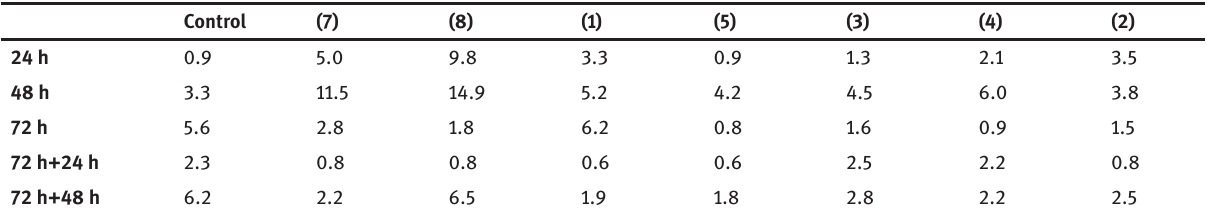
Table 1: The percentage of apoptotic HL60 cells cultured in the presence or absence of 100 μM of coumarin derivates for up to 3 days. Two latter rows show the results obtained after washing out the coumarins.